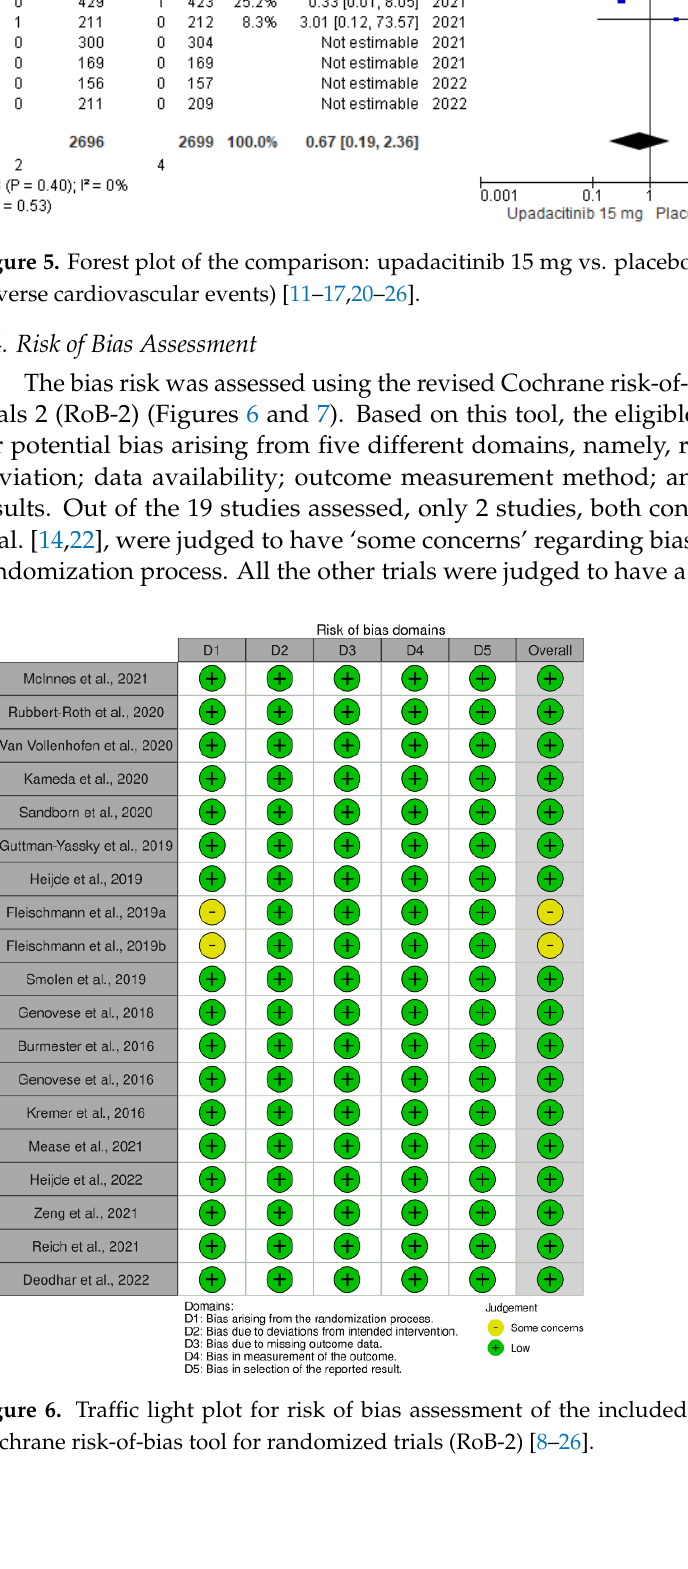
Figure 6. Traffic light plot for risk of bias assessment of the included studies using the revised Cochrane risk-of-bias tool for randomized trials (RoB-2) [8 – 26].